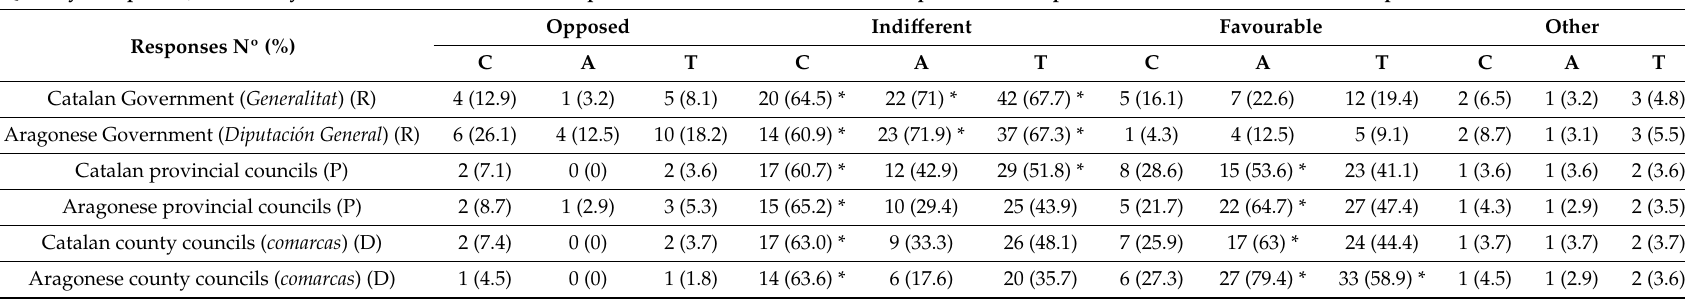
Table 9. Answers obtained in Q7 (source: